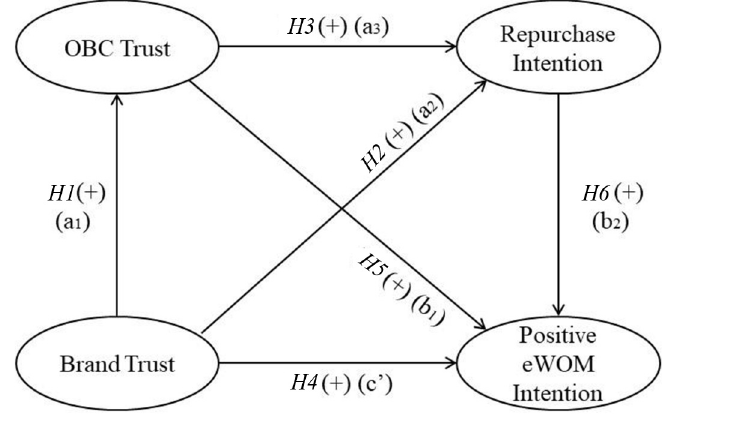
Figure 1. Research